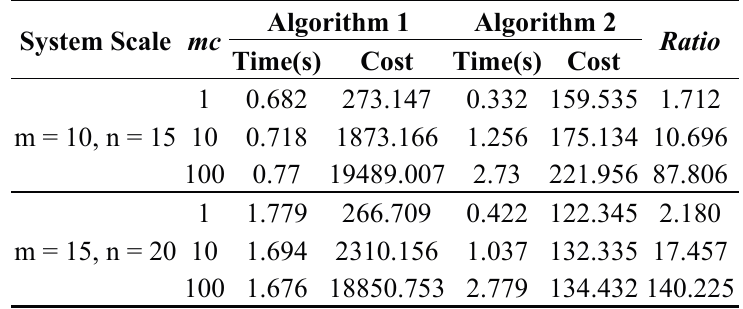
Table 5. Simulation result for the imperfect test cases (N = 100, L = 3).